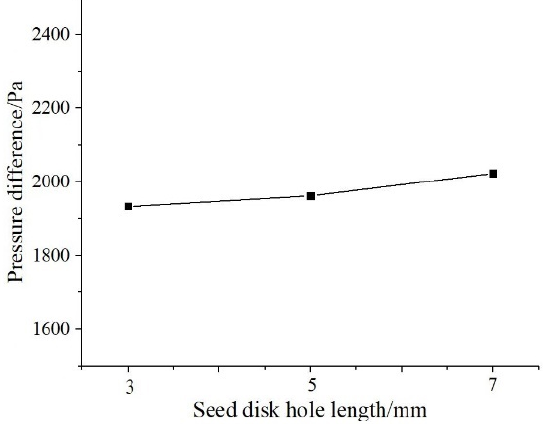
Figure 14. Influence of the seed disk hole length on the average pressure difference.